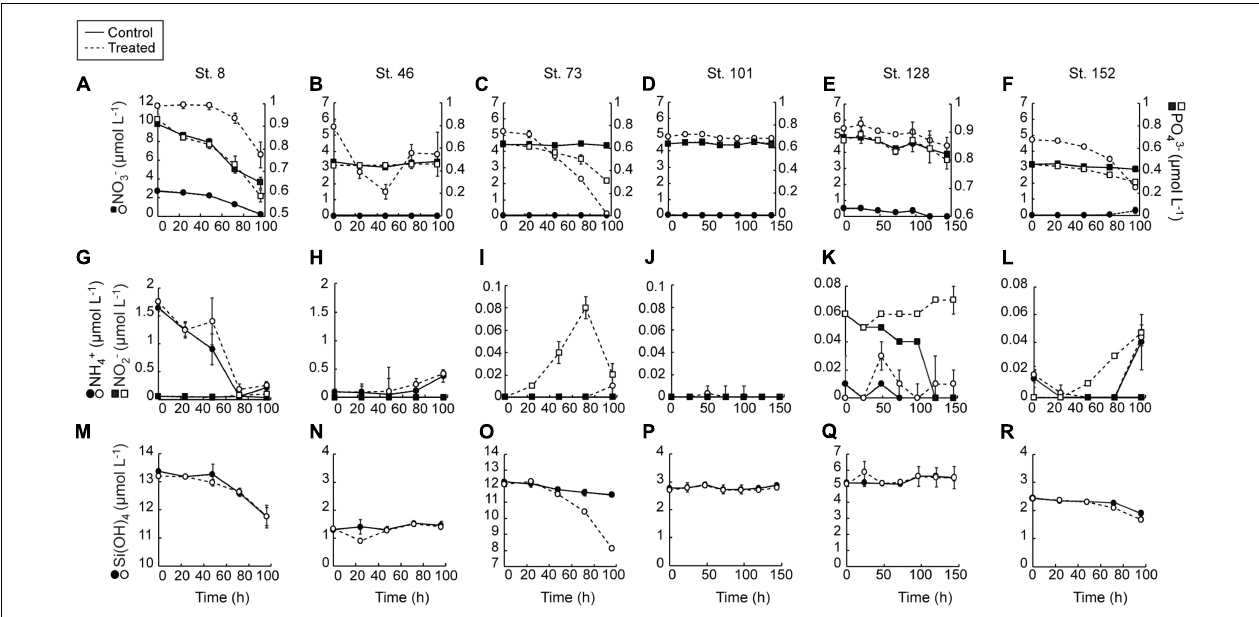
FIGURE 2 | Average ( ± SD) nutrient concentrations measured during the nutrient amendment experiments. Solid lines are control and dashed lines are treated bottles. NO 3 − and PO 43 − (A–F) , NH 4 and NO 2 − (G–L) , Si(OH) 4 (M–R) .